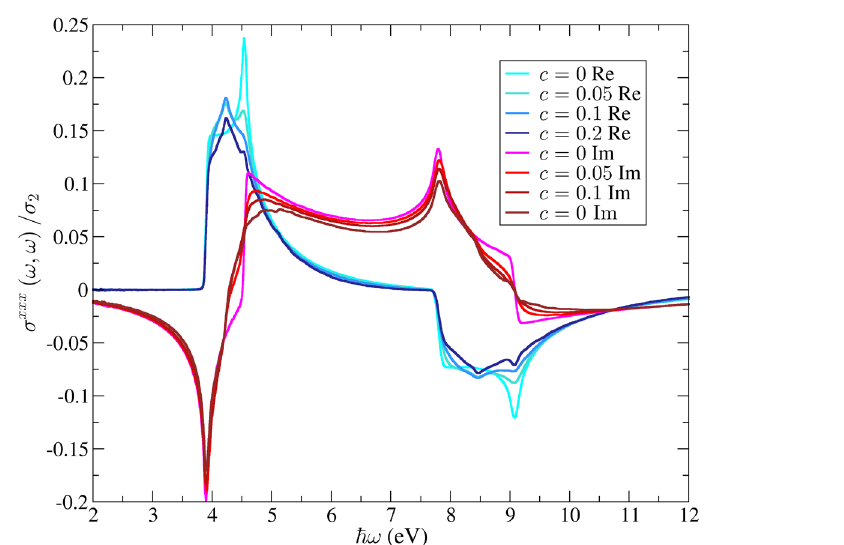
Figure 4. Second-harmonic generation in gapped Graphene for a varying concentration of vacancies and γ = 2 . 3 meV. The blue (red) curves represent the real (imaginary) part of the conductivity. The darker curves have a higher concentration of vacancies. All the parameters are the same as in Figure